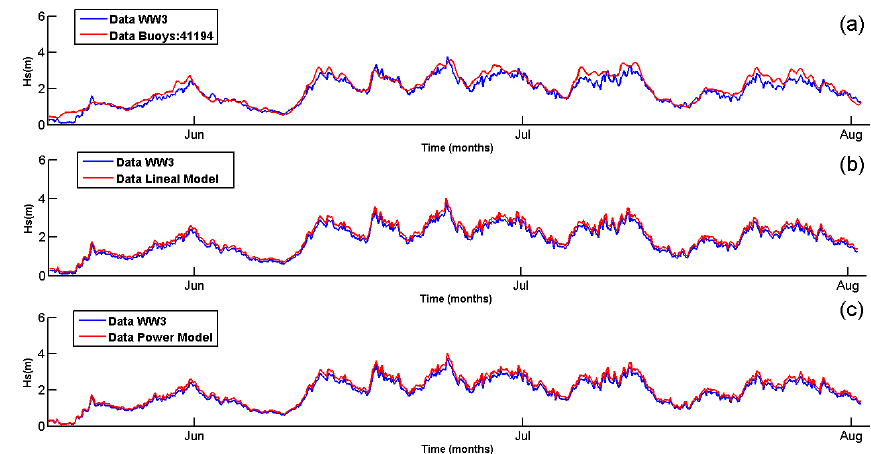
Figure 3. Validation of the H s time series ( m ) corresponding to the year 2009 ( n = 767). (a) Buoy 41194 and WW3 data without calibration. (b) Buoy 41194 and data corrected with the linear model. (c) Buoy 41194 and data corrected with the power model.